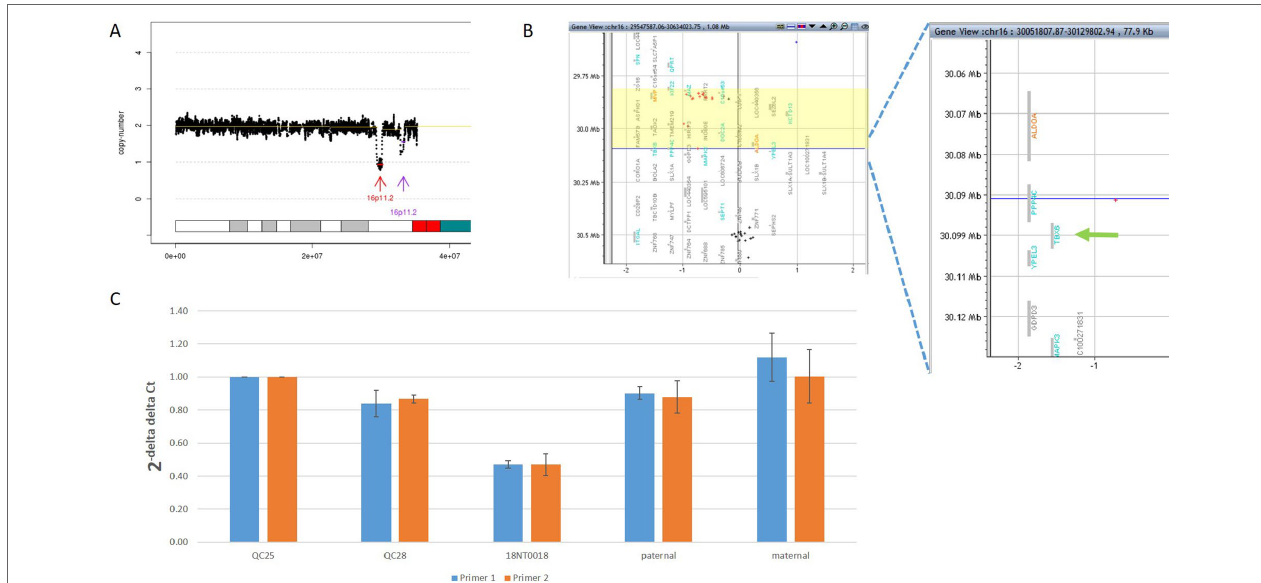
FIGURE 4 | Comprehensive delineation of 16p11.2 recurrent deletion syndrome. In 18NT0018, (A) GS reported a 751.9-kb de novo pathogenic deletion seq[hg19] del(16)(p11.2) chr16:g.29538256_30290160del (indicated by a red arrow) and a polymorphism deletion (population-based U test P > 0.01, indicated by a purple arrow) in chromosome 16p11.2; (B) original CMA reported a 259.0-kb heterozygous deletion arr[hg19] 16p11.2(29832358_30091372)x1 highlighted in yellow and without a probe locating in gene TBX6 ; (C) quantitative PCR two independent pairs of primers targeting TBX6 shows approximately 0.5 copy ratio in 18NT0018 compared with normal control (Q25). The parental experiments confirmed that the heterozygous deletion in 18NT0018 is in de novo